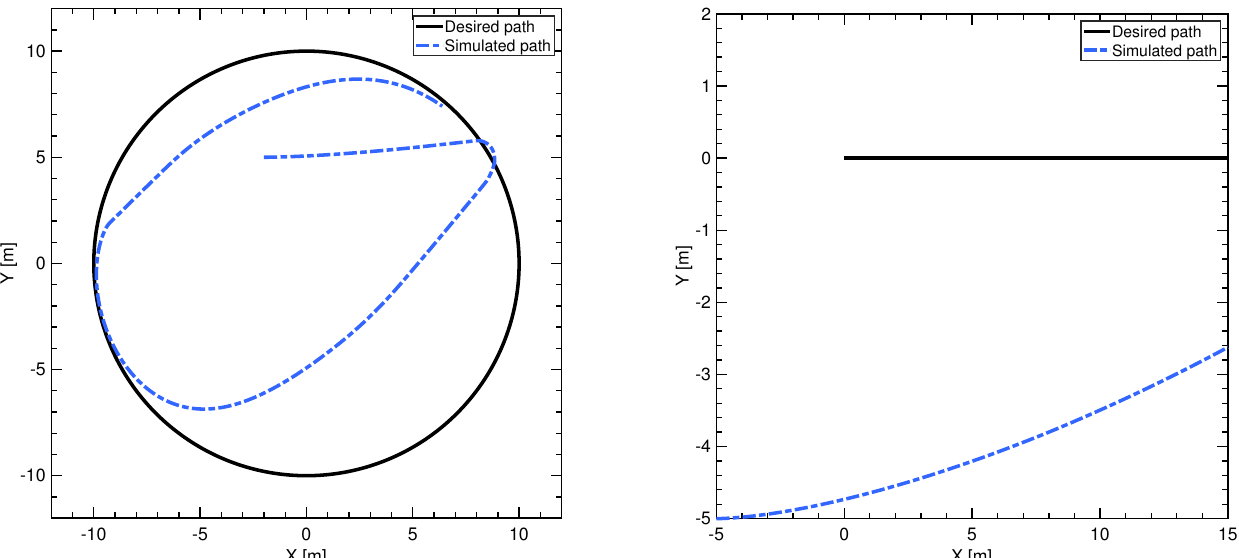
Figure 24. Trajectory following test in case of incorrect tractive force estimation: circular path ( left ) and straight path ( right ).